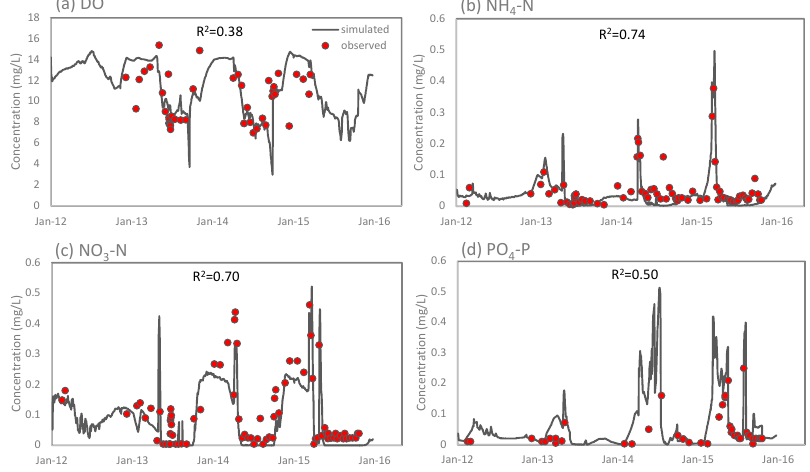
Figure 8. Calibration (2014–2015) and validation (2012–2013) results for simulated versus observed water quality data ( a ) DO; ( b ) NH 4 -N; ( c ) NO 3 -N; and ( d ) PO 4 -P at Marquis Bridge. Figure 9 compares the measured water quality concentrations and the outputs from the calibrated/validated WASP7 model and from climate change scenarios (i.e., the average of the outputs from all the climate change scenario models). The climate change scenario models were based on the simulated water temperature and ice cover period using historical down-scaled climate data. The 16-year averaged daily flow data at 05JG006 and 05JG013 flow gauges (Figure 1) were used for the climate change model. The 16-year averaged monthly historical concentrations of the water quality parameters including NH 4 -N, NO 3 -N, DON, PO 4 -P, OP, Chl a, and DO were available at the SK05HF026 monitoring station (Figure 1) and 5-year averaged monthly water quality parameter concentrations (NH 4 -N, NO 3 -N, DON, PO 4 -P, OP, and DO) were available at the Ridge Creek and Iskwao Creek monitoring stations (Figure 1) and were used for the climate change model. The mean simulated concentrations matched the measured mean concentrations relatively well.